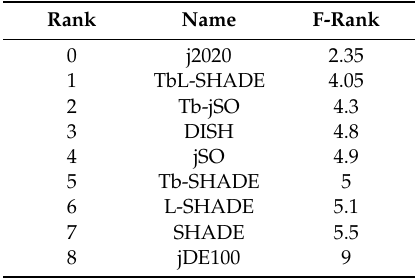
Table 38. The Friedman ranks of comparative algorithms on CEC2020 in 20 D